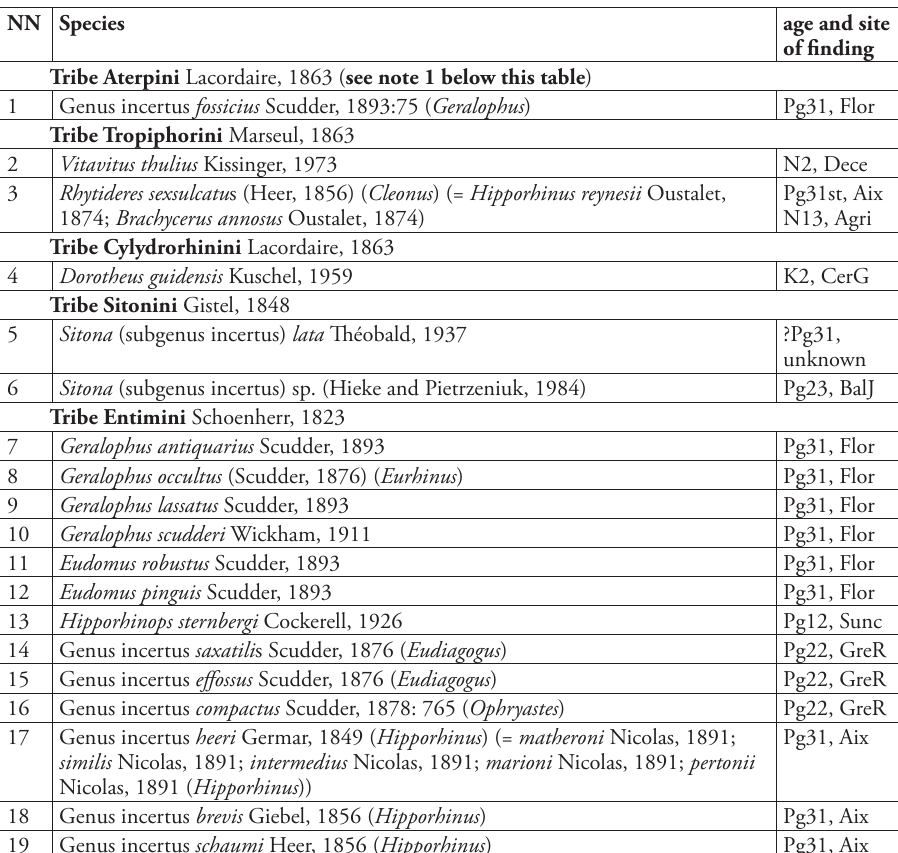
Table 2. Checklist of prepleistocene fossil Entiminae. Subfamilia Entiminae Schoenherr,